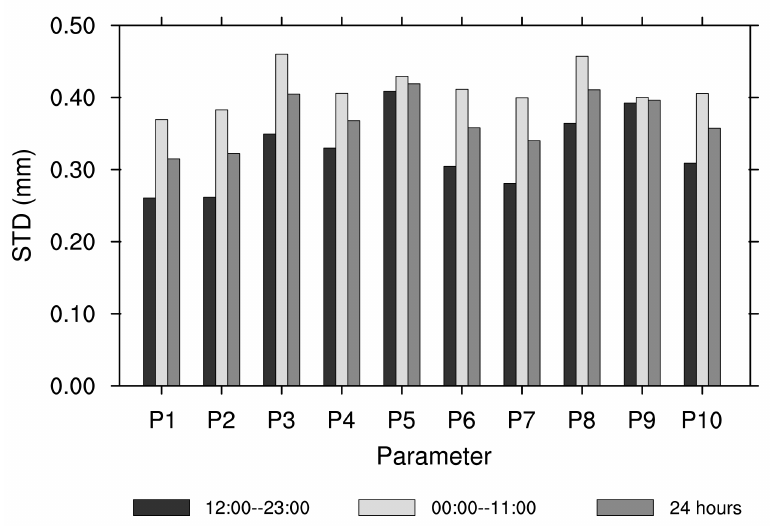
Figure 17. The comparison of the mean STD of hourly precipitation during different